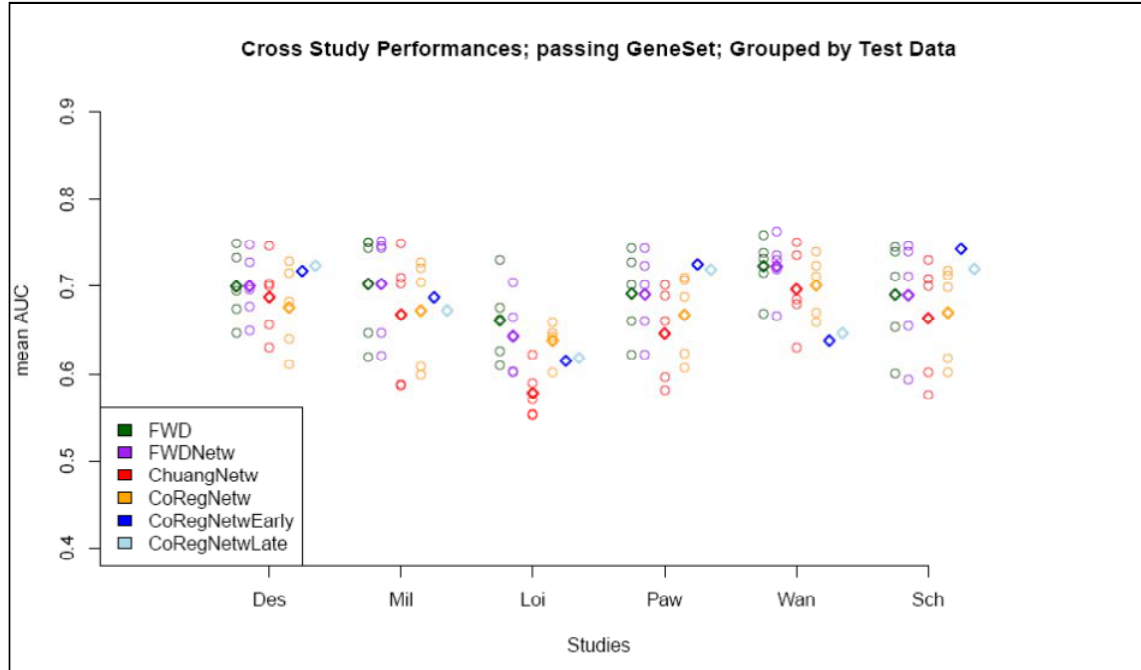
Figure 6: Cross study prediction performances of several methods grouped per evaluation study in the “ passing Classifier ” setting. Circles indicate results of cross study prediction performances involving a single study for training, diamonds show results involving five studies for training. The latter can either be a summarization statistic (mean) or be the result of an integration approach (CoRegNetwEarly and